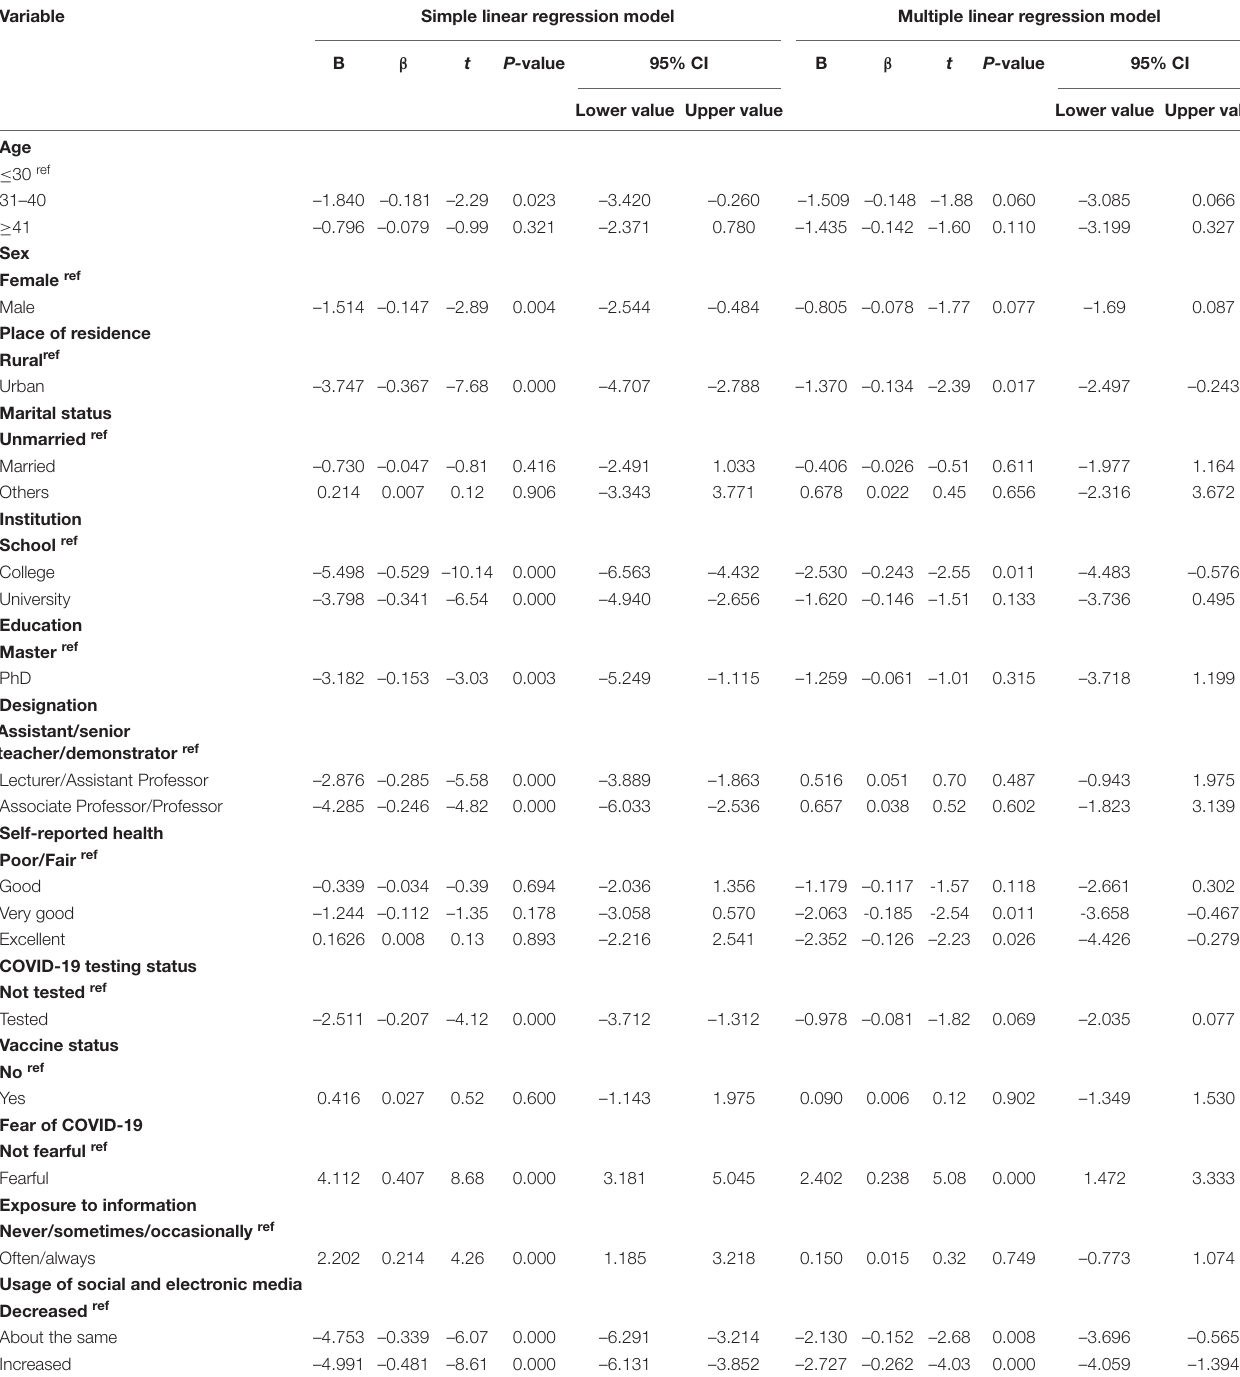
TABLE 2 | Predicting depression among teachers during the COVID-19